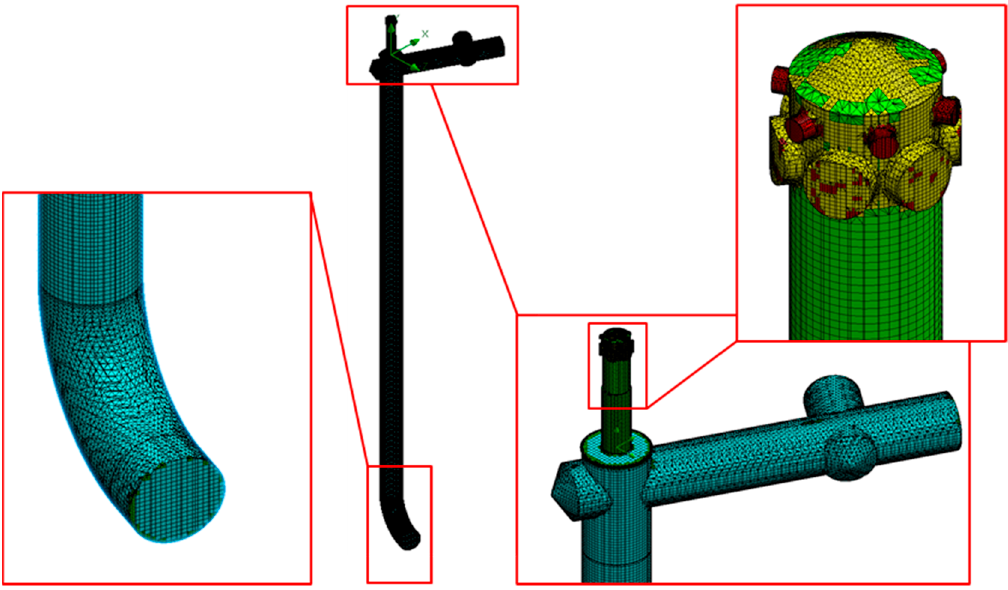
Figure 7. Numerical grid developed to analyse fluid flow in the safety elements using CFD method.